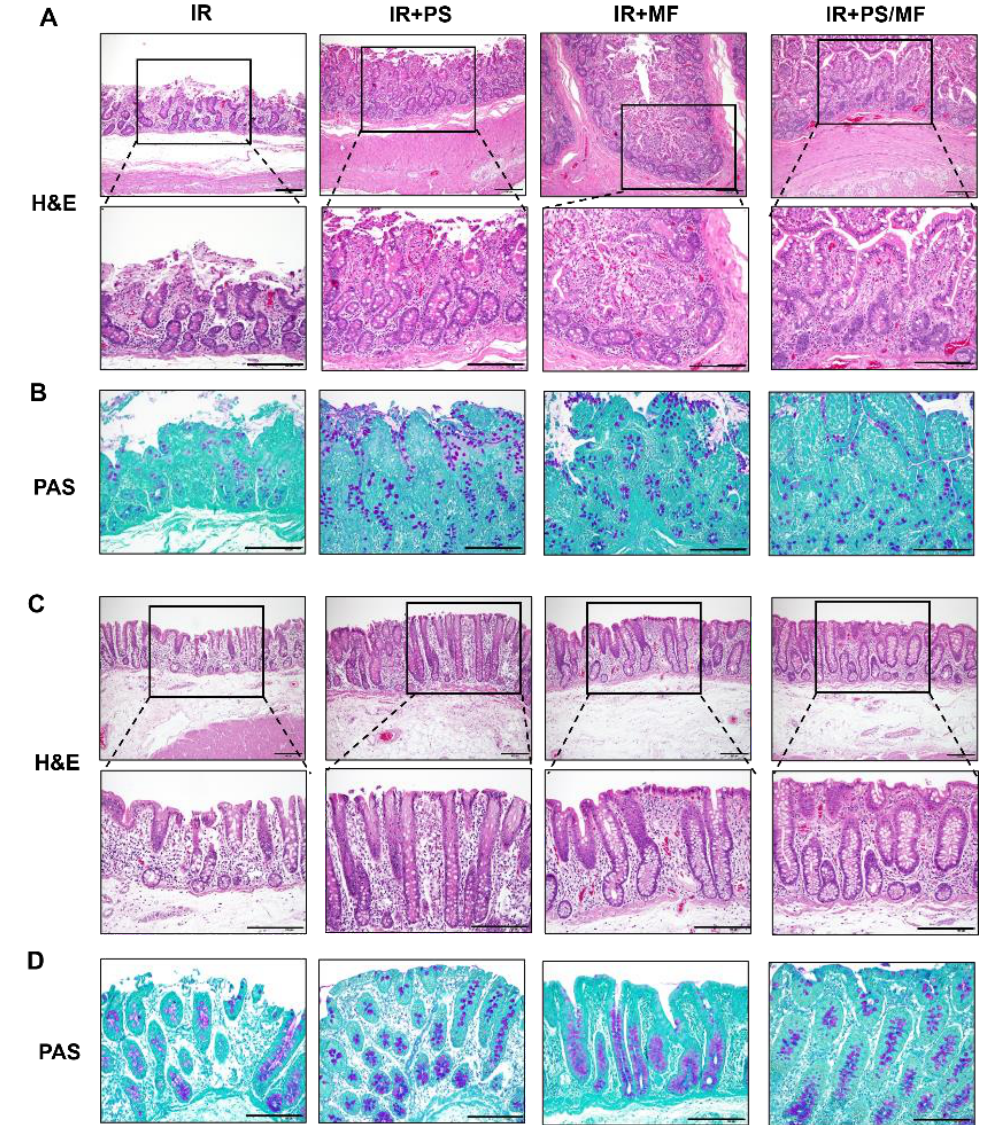
Figure 5. Effect of combined pravastatin and metformin treatment on histological damage of the intestine in the irradiated minipig model. ( A ) Hematoxylin & Eosin (H&E) staining of small intesti- nal tissues harvested from irradiated (IR), pravastatin-treated IR (IR + PS), metformin-treated IR (IR + MF), combined PS and MF-treated IR (IR + PS/MF) minipigs. Bar = 200 µ m. ( B ) Periodic Acid Schiff (PAS) staining of small intestinal tissues harvested from IR, IR + PS, IR + MF, IR + PS/MF groups. Bar = 200 µ m. ( C ) H&E staining and ( D ) PAS staining of large intestinal tissues harvested from IR, IR + PS, IR + MF, IR + PS/MF groups. Bar = 200 µ